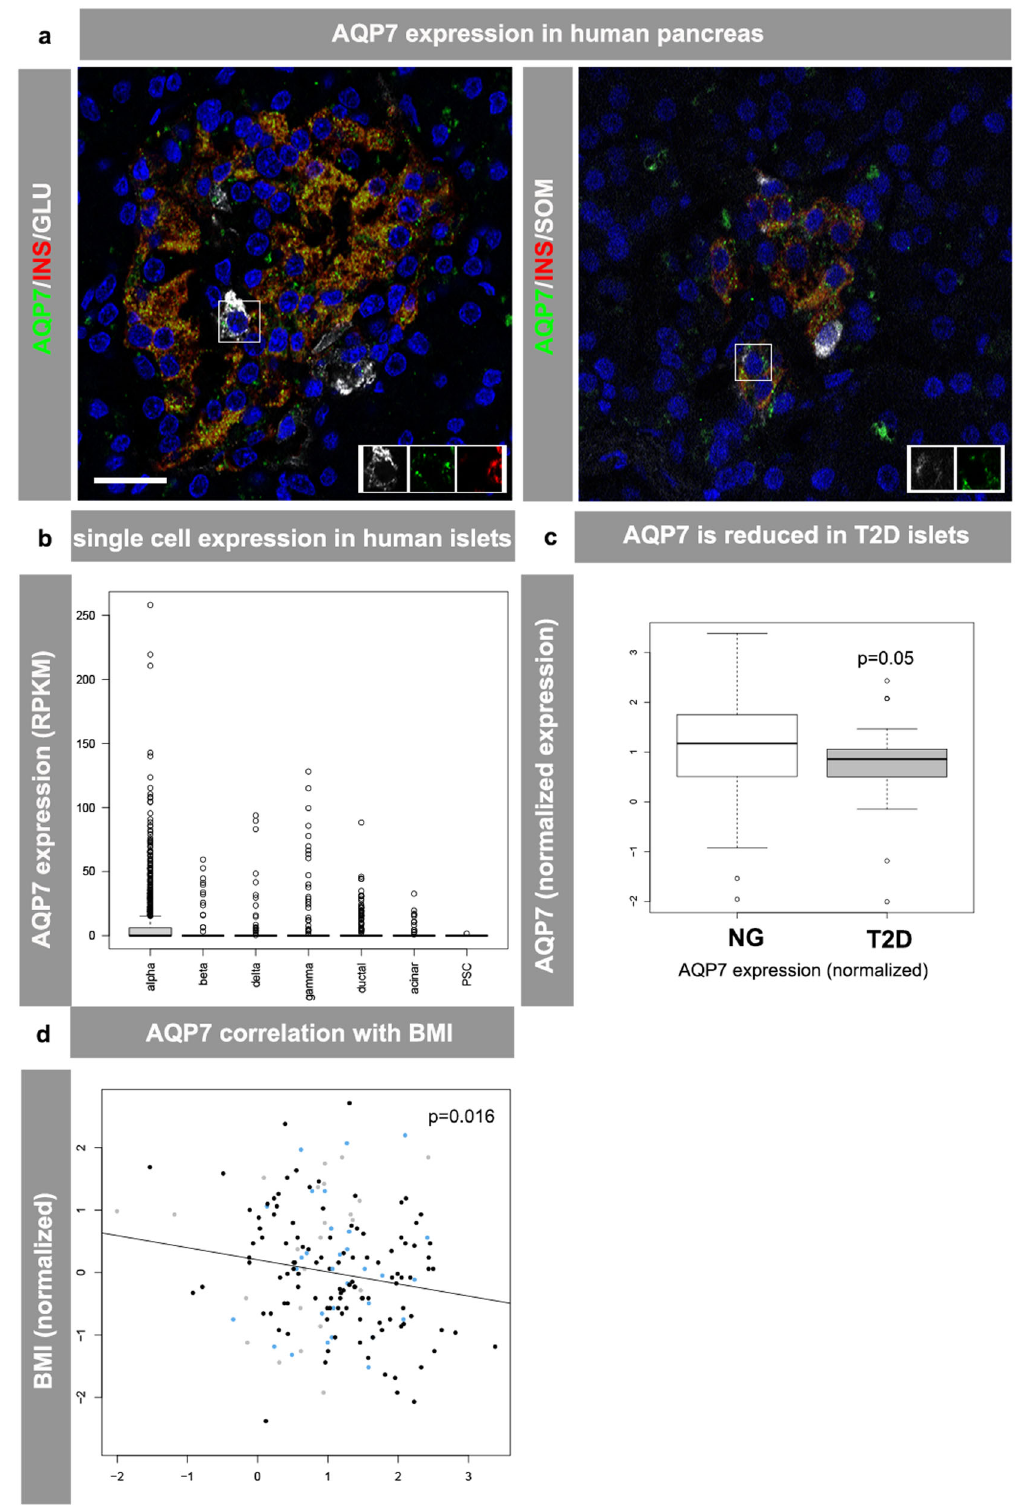
Fig. 1 | AQP7 expression in human pancreatic islets. Immunohistochemistry staininginhumanpancreassectionsfromnormoglycemicdonorsfor( a )left:AQP7 (green), insulin (red), and glucagon (white), right: AQP7 (green) and insulin (red), somatostatin (white). Nuclei are blue, scale bar is 20 µ m, inserts illustrate co- expression of AQP7 with insulin and glucagon (left panel) and somatostatin (right panel). b Single cell RNAseq expression of AQP7 in human pancreatic cells from 37 ( n =10: NG=6, T2D=4). c AQP7 expression in islets from normoglycemic donors and donors diagnosed with T2D (NG=155, T2D=33 donors). All box plots include themedianline,theboxdenotestheinterquartilerange(IQR),whiskersdenotethe